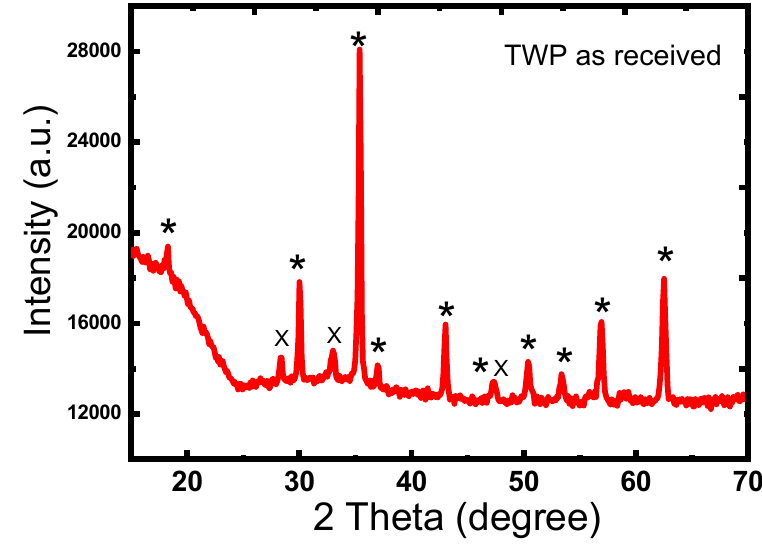
Figure 2. XRD of TWP after drying in air atmosphere at 80 °C for 1 hr: Fe 2 O 3 (*) and CeO 2 (x).